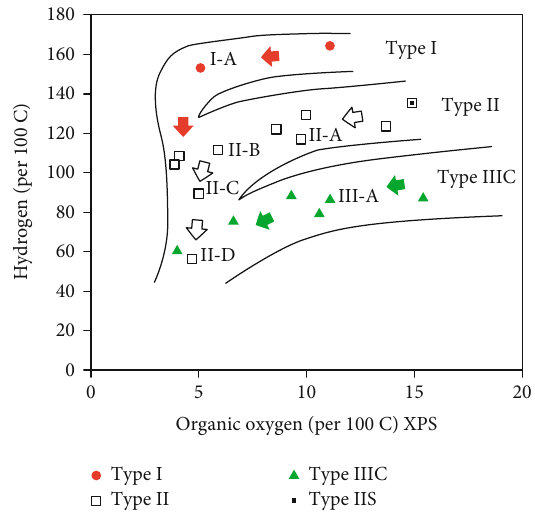
Figure 2: Van Krevelen diagram of kerogen maturation [59]. Table 2: Seven kerogen con fi gurations constructed.